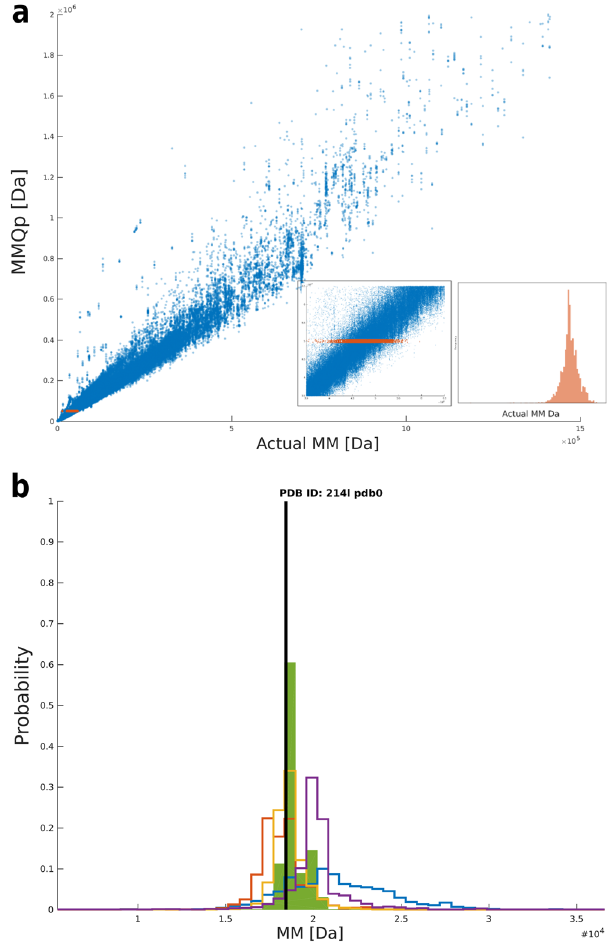
Figure 2. Overview of the method of Bayesian inference. ( a ) Scatter plot of actual MM (from CRYSOL) vs. the estimated MM (in this case, MM Qp ). Given the evidence of a MM from MM Qp equal to 50 kDa, a distribution is created by extracting the actual MMs (from CRYSOL) of when MM Qp = 50 kDa, shown as the red points, and the corresponding distribution in the inlet figure. ( b ) Example of the Bayesian inference method for a randomly chosen protein, here PDB ID: 214l. The probability distributions of the molecular weights for each of the methods (MM Qp : blue; V c : red; MoW: yellow; Size&Shape: purple) are combined through the Bayesian calculation (green distribution). The most probable MM coincides with the actual MM (black